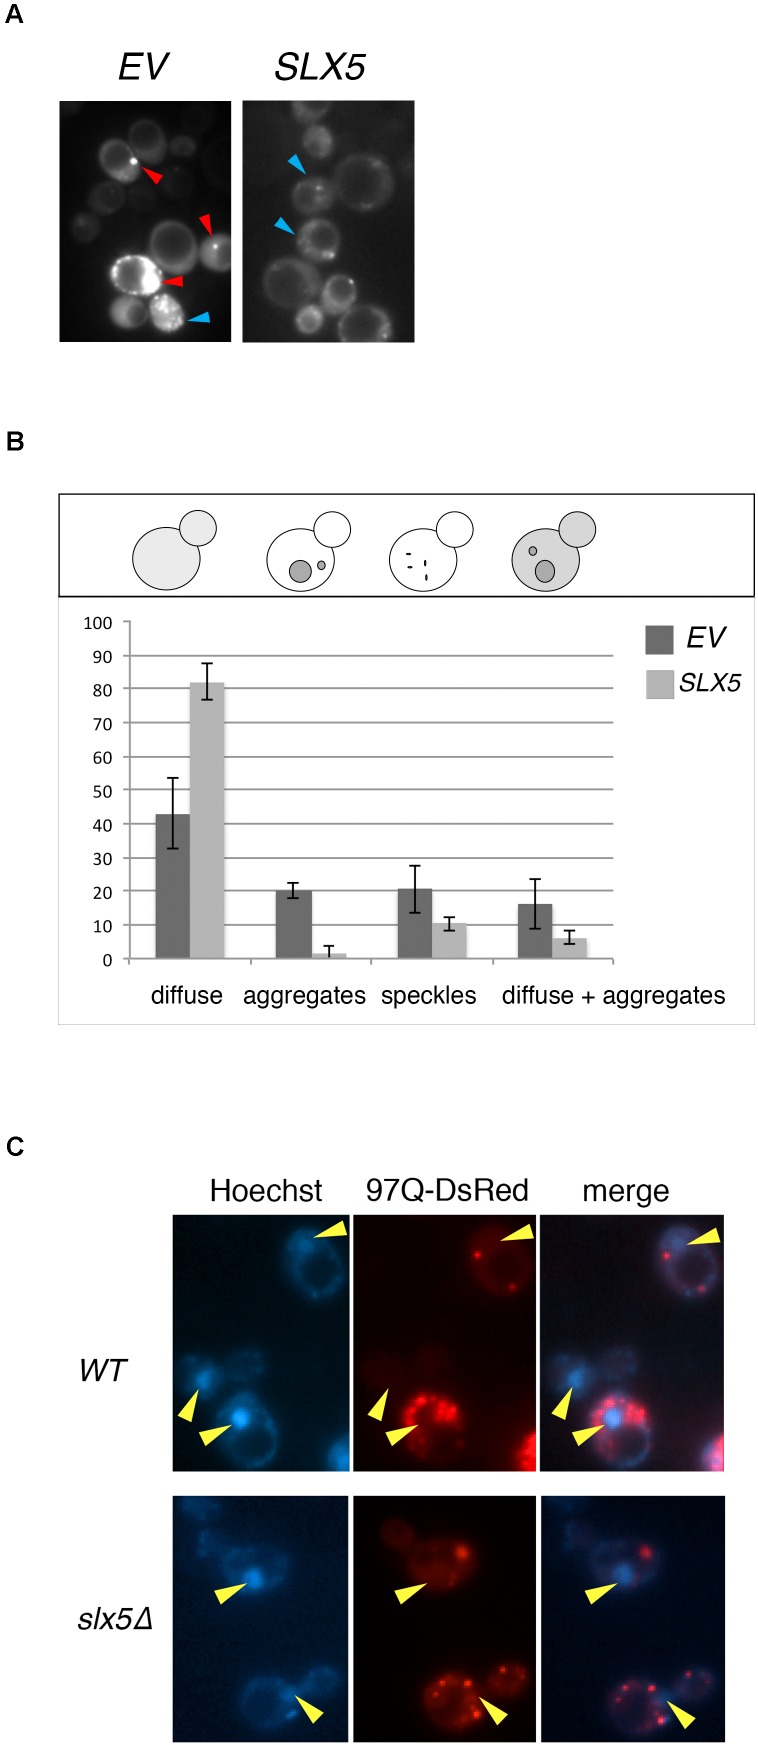
Plasmid-borne SLX5 reduces aggregates of poly-Q expanded huntingtin. (A) Representative images of Htt-103Q in WT cells with and without an SLX5/CEN plasmid. Example of aggregates (clearly defined, bright cytoplasmic structures – red arrow-heads) and speckles (multiple small, not clearly defined cytoplasmic granules – blue arrow-heads) (B) Quantitation of phenotypes observed in 2A. WT strain expressing Htt-103Q-GFP alone (YOK 2842) or Htt-103Q-GFP with SLX5 (YOK 2843) were grown to mid-logarithmic phase in selective medium. Images of 103Q diffuse staining, aggregates, and speckles in the indicated strains were recorded and then quantitated. Average counts for three independent experiments were graphed +/− standard deviation. Y-axis: percent of cells (n = 100/experiment). Y-axis: phenotypes scored (C) Aggregates of poly-Q expanded Htt are localized in the cytoplasm. WT and slx5Δ strains transformed with GAL-Htt-97Q-DsRed (YOK 3112 and YOK 3114) were grown overnight in SC-TRP medium with 2% raffinose. Cultures were diluted to ∼0.2 OD in a fresh medium with 2% galactose and incubated for an additional 16 h for expression of Htt-97Q-DsRed prior to imaging Htt aggregates using a fluorescence microscope. Nuclei were stained with Hoechst dye. Merged images indicate the absence of Htt-97Q aggregates in nuclei (yellow arrow-heads).